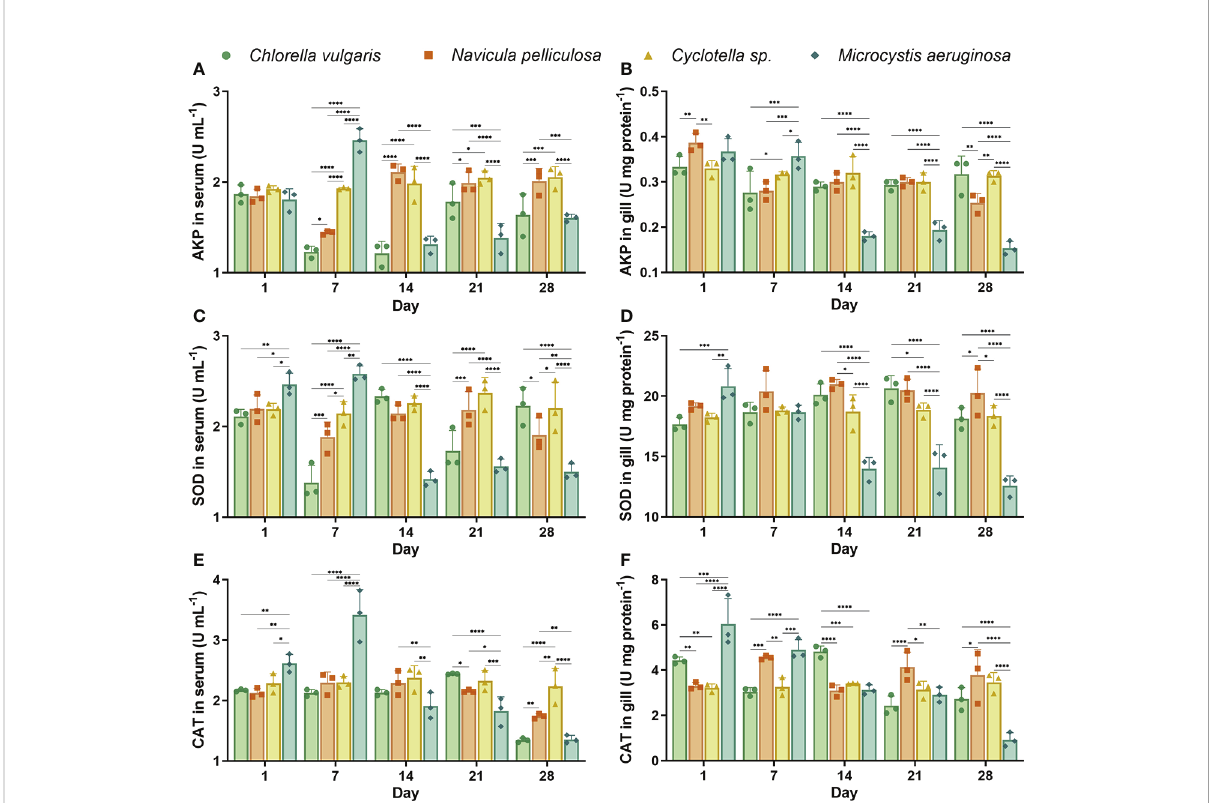
FIGURE 3 Activities of immune enzymes in serum and gill of Hyriopsis cumingii . Mussels exposed to four different microalgae treatments on days 1, 7, 14, 21, and 28. Immune enzyme activities in serum: (A) AKP, (C) SOD, and (E) CAT. Immune enzyme activities in gill: (B) AKP, (D) SOD, and (F) CAT. The asterisk (*) indicates signi fi cant differences between four microalgae treatments at each sampling time (Tukey test, p < 0.05). Values are expressed as mean ± SD (n = 3). AKP, alkaline phosphatase; SOD, superoxide dismutase; CAT, catalase. The symbols *, ** , *** and **** represent p < 0.05, p < 0.01, p < 0.001 and p < 0.0001